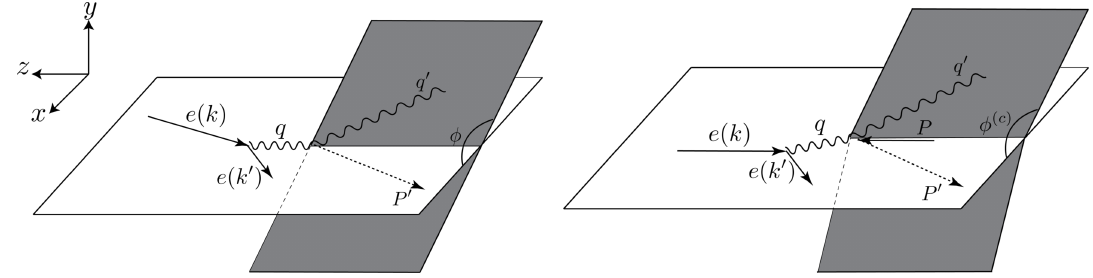
Figure 1 . The coordinate choice for fixed-target experiments (left) and the collider experiments (right), where the target momentum is not shown for the fixed-target plot. The z -axis in the fixed- target coordinates is chosen such that the virtual photon momentum ~q is in − z direction, whereas the z -axis in the collider coordinates is defined by the electron beam ( − z direction) and proton beam ( + z